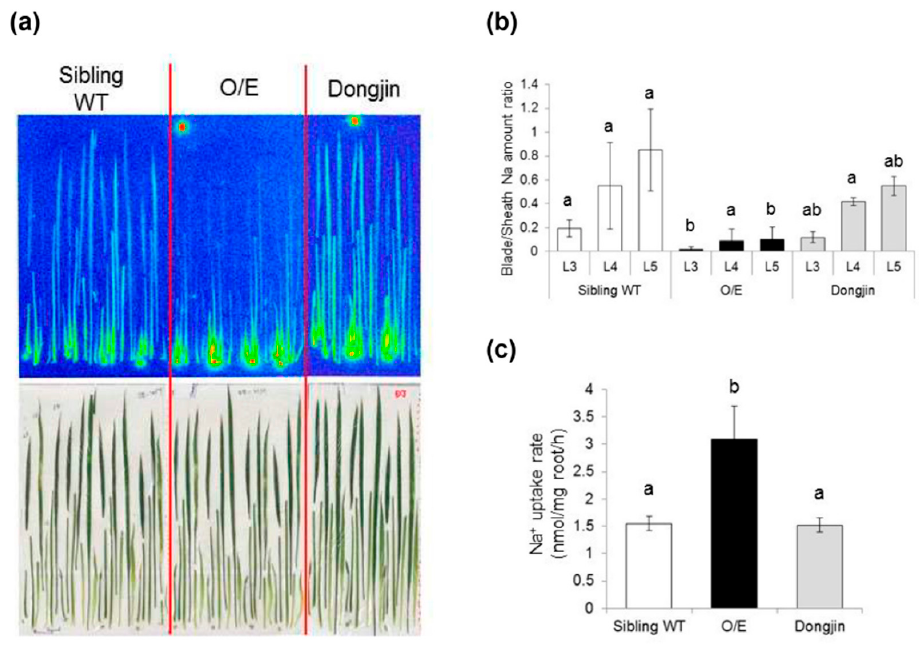
Figure 3. 22 Na tracer experiments using O/E and WT plants. ( a ) Allocation of 22 Na in the shoot of rice plants. The autoradiograph (the upper image) and the picture of the sample (the lower image) were presented. All of the seedlings were composed of sheaths of the 1st leaf (L1), L2, and L3, L3 blade, L4 sheath, L4 blade, L5 sheath, L5 blade, L6, and the basal part of the shoot; ( b ) Na distribution ratios between the blade and the sheath of 3rd, 4th, and 5th leaves; ( c ) Sodium uptake rate (nmol/mg root/h) in the nutrient solution containing 10 mM NaCl. The means with standard deviations were presented ( n = 3 for Dongjin and n = 4 for the O/E and the sibling WT). Different alphabets in (b) and (c) represent significant differences at the level of 5% (Tukey-Kramer method).